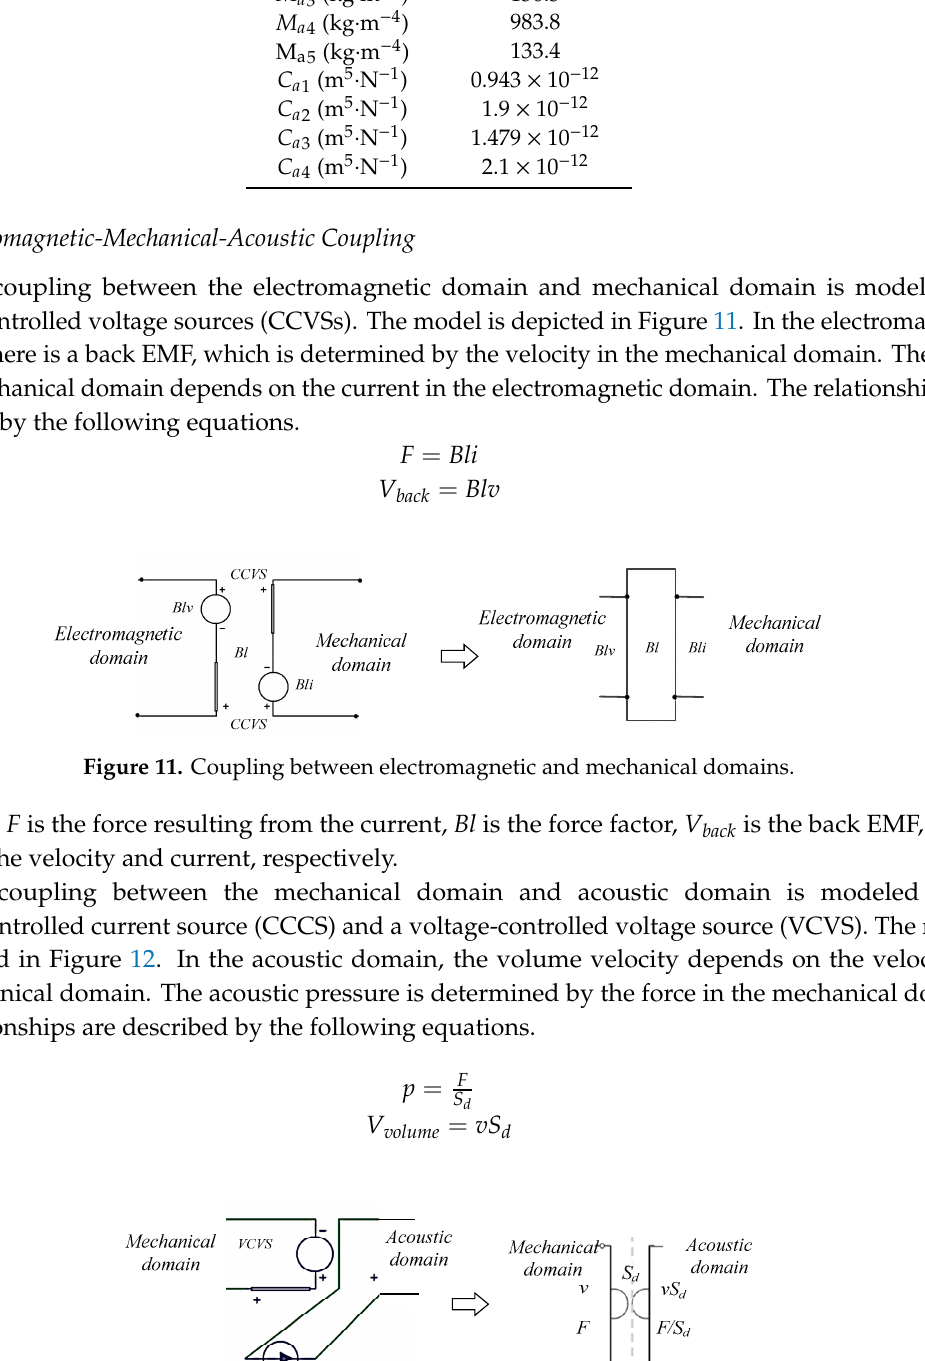
Table 1. Parameters of IEC-60711 coupler. Figure 10. Cross-section view and equivalent circuit of IEC-60711 coupler.